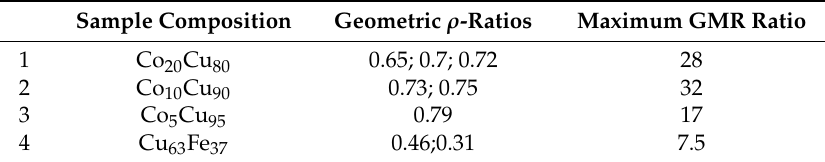
Table 3. Compositions and maximum GMR ratio of glass-coated microwires with granular structure.